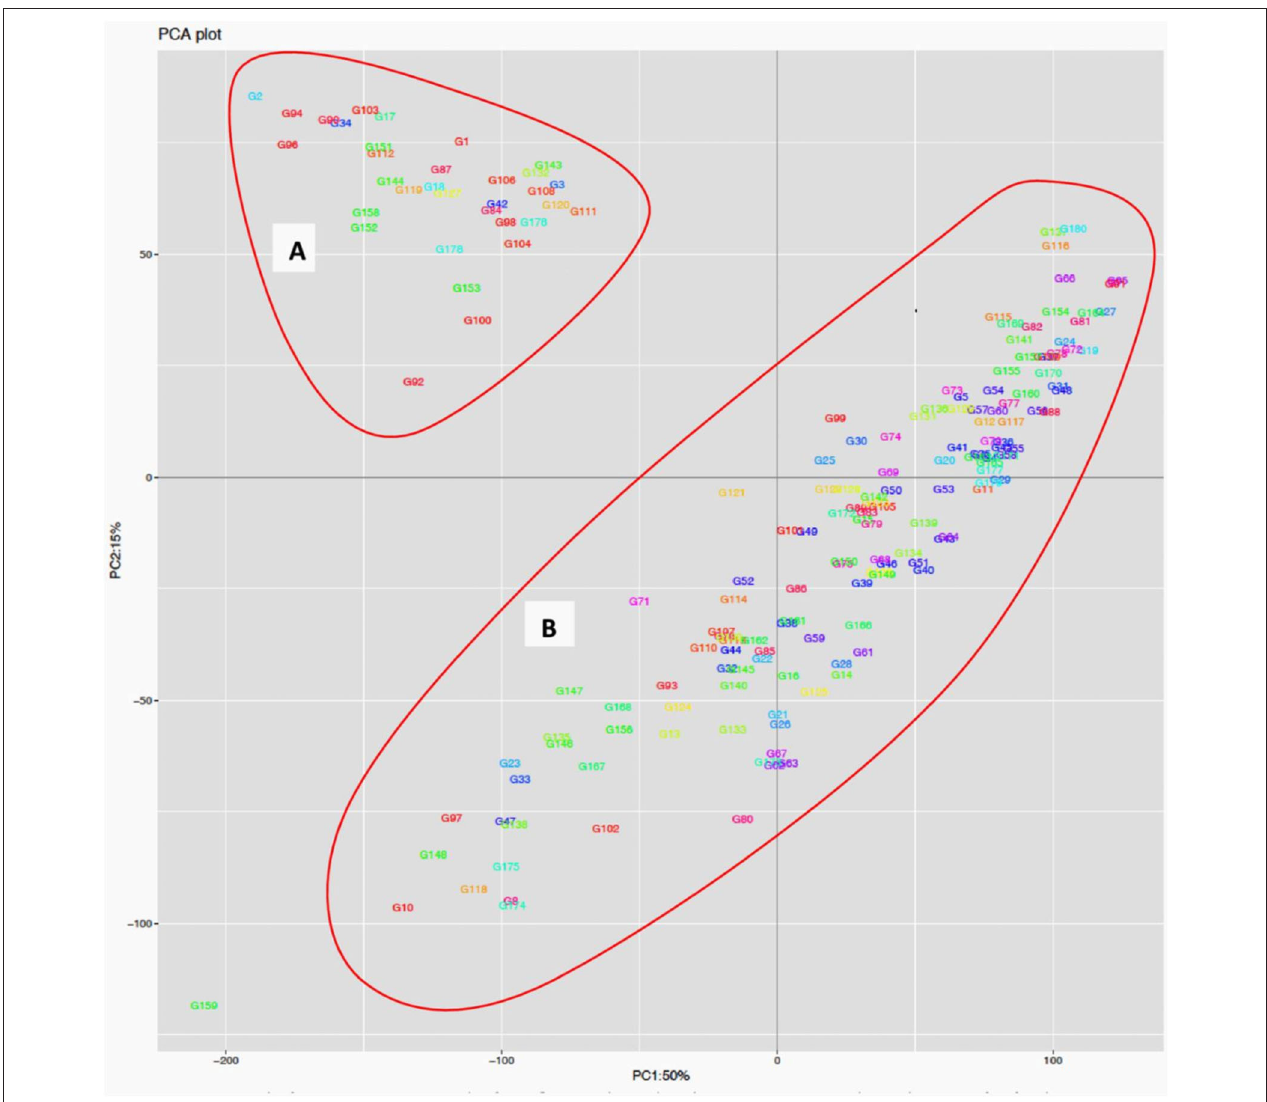
FIGURE 3 | Population structure analysis of the 178 bread wheat genotypes based on principal component analysis clustering as revealed by the first two principal components. Samples coded with the same color belong to same population. Cluster (A) composed of 33 (18.54%) genotypes while Cluster (B) possessed 145 (81.46%) of the